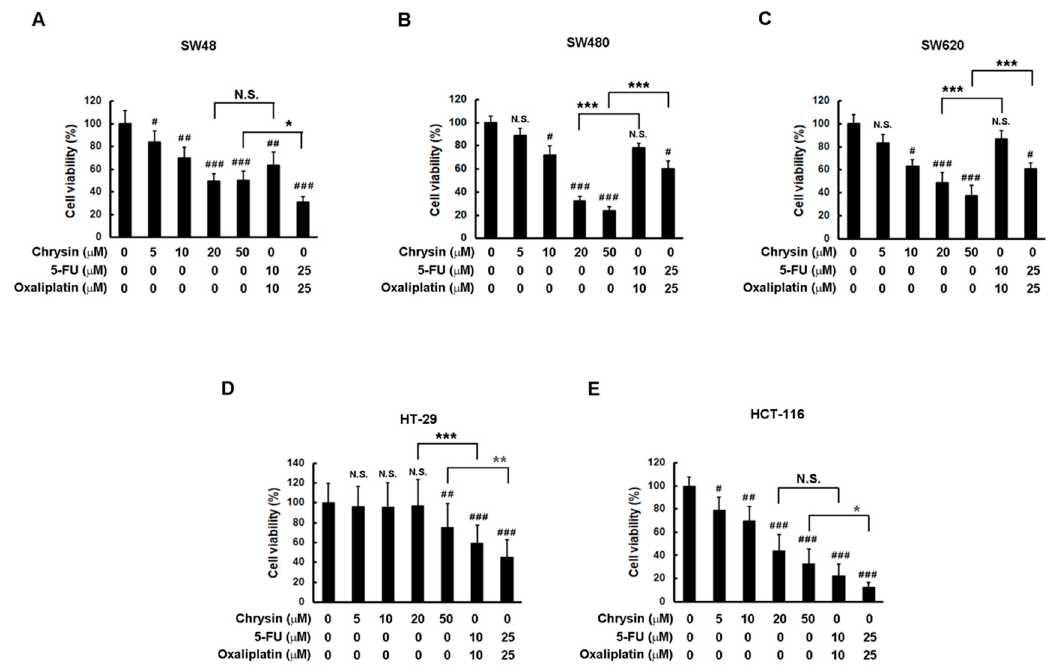
Figure 1. Chrysin achieved similar effectiveness to 5-fluorouracil (5-FU) combined with oxaliplatin in a panel of colorectal cancer (CRC) cells. ( A – E ) Each CRC cell line was treated with the indicated concentrations of chrysin or 5-FU and oxaliplatin for three days. Cell viability was determined via a 3-(4,5-dimethylthiazol-2-yl)-2,5-diphenyltetrazolium bromide (MTT) assay, and was statistically quantified. # p < 0.05; ## p < 0.01; ### p < 0.001 when compared with control (vehicle only) groups. * p < 0.05; ** p < 0.01; *** p < 0.001 when compared with indicated control groups. A p -value < 0.05 was considered as statistically significant. N.S.—not significant.